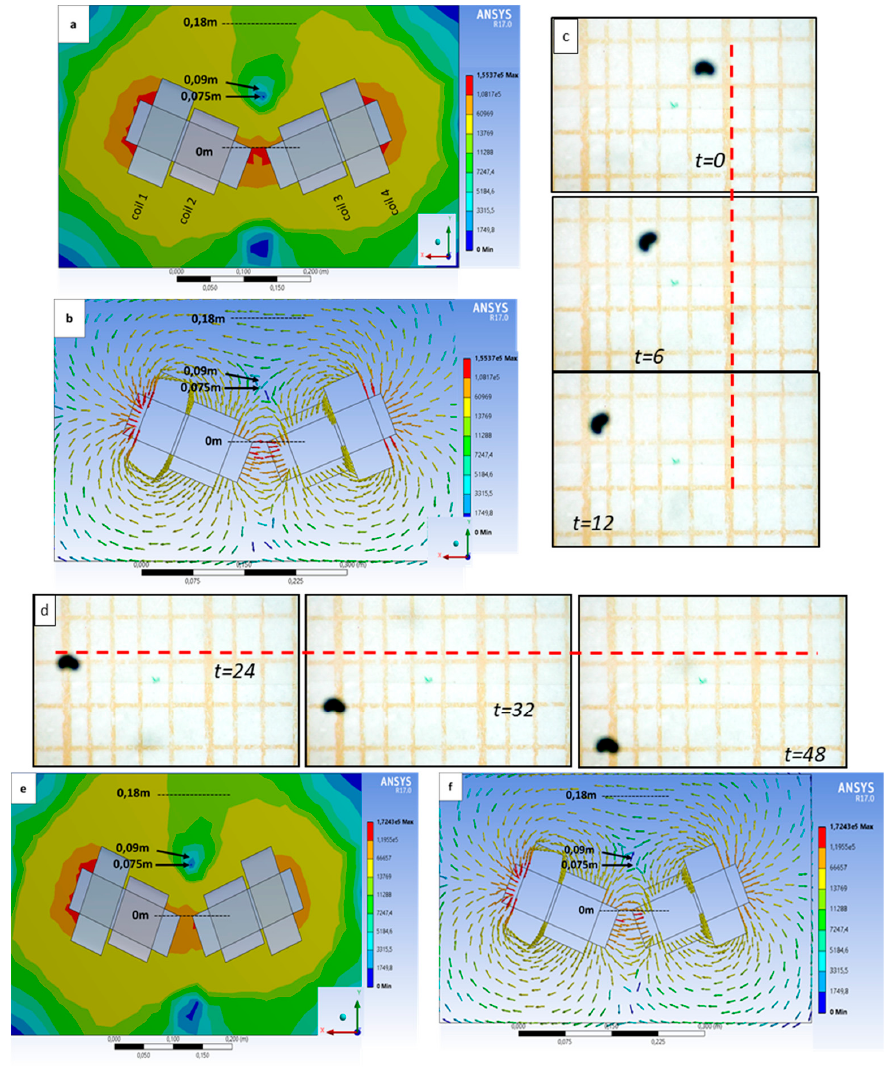
Figure 5. ( a , b ) Simulations of the magnetic field intensity and the vectors of the field for currents used to push forward the droplet. ( c ) The positions of the droplet at t = 0, 6, and 12 s. ( d ) The position of the droplet for t = 24, 32, and 48 s. ( e , f ) Simulations of the magnetic field intensity and the vectors of the field for currents used to deflect the droplet. Note the change of direction of the vector in the cancellation node (arrows) in ( b , f ) due to different current supply to the four coils. The measurements are taken on the centerline starting from the last point of the cores (dashed lines). The scale bars are in meters.